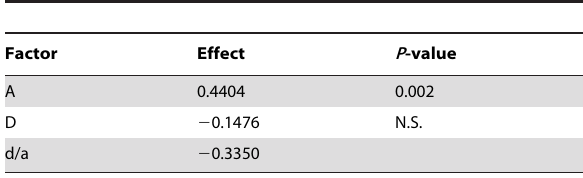
Table 4. Genetic effects of SNP3593 for IDH activity.